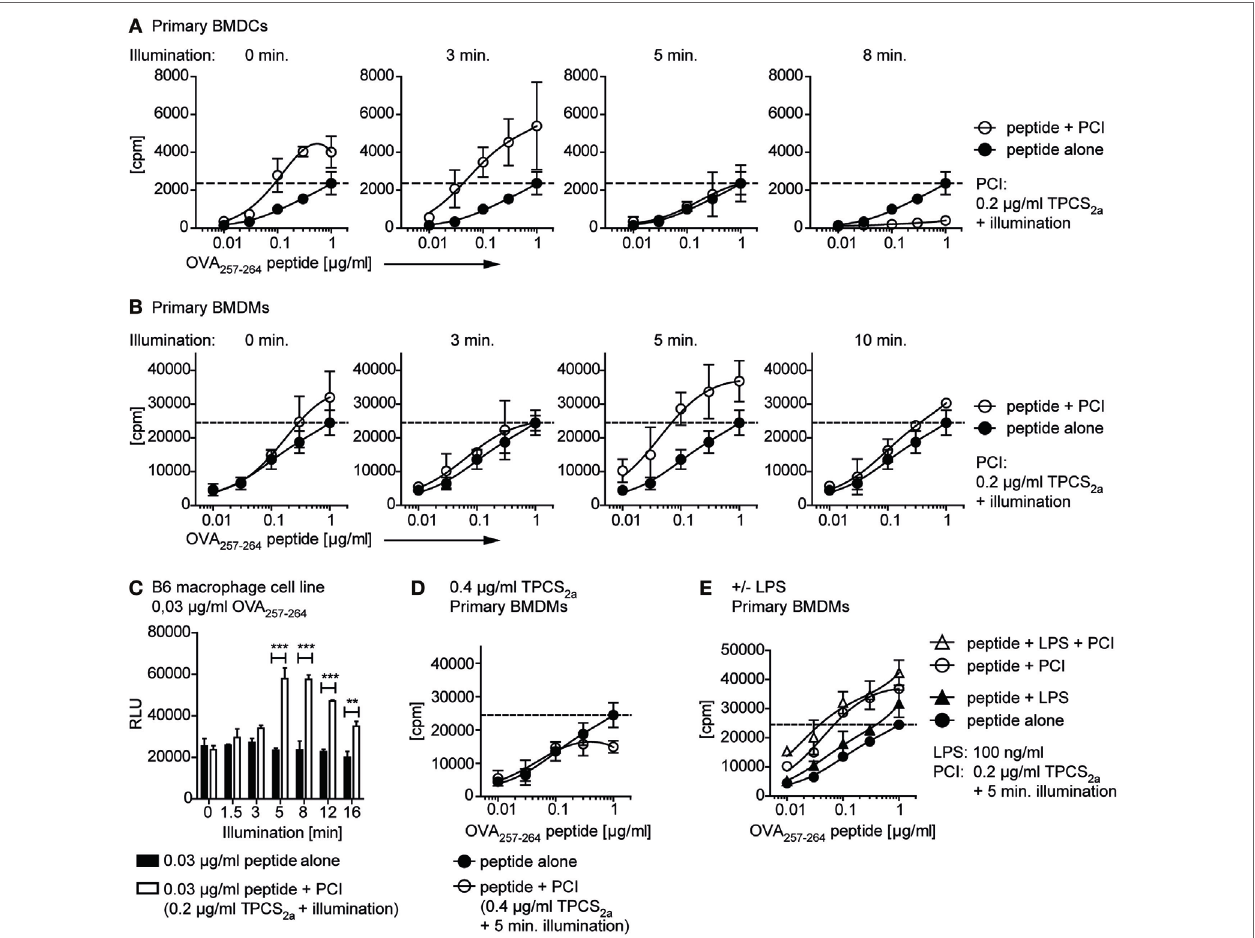
FigUre 4 | Photochemical internalization (PCI)-mediated peptide antigen delivery to antigen-presenting cells enables CD8 + T cell activation with very low doses of peptide. Primary bone marrow-derived dendritic cells (BMDCs), primary bone marrow-derived macrophages (BMDMs), or the B6 macrophage cell line were incubated ± TPCS 2a and OVA 257–264 peptide as described in Figure 3 . Cells were illuminated, before ovalbumin-specific RF33.70 CD8 + T cells were added overnight and IL-2 from activated CD8 + T cells was analyzed in a bioassay from cell culture supernatants. The PCI-effect on RF33.70 CD8 + T cell activation with 0.01–1 µg/ ml OVA 257–264 OVA 257–264 peptide was analyzed in primary BMDCs (a) and primary BMDMs (B) . The graphs show results for CD8 + T cell activation with peptide alone (closed symbols) or peptide delivered by PCI (0.2 µg/ml TPCS 2a , open symbols) and increasing illumination times from 0 to 10 min. The dotted line indicates the maximal CD8 + T cell activation achieved with 1 µg/ml OVA 257–264 peptide without PCI treatment. (c) Effect of PCI treatment on OVA 257–264 -specific CD8 + T cell activation with a single, low concentration of 0.03 µg/ml OVA 257–264 peptide and increasing illumination times. OVA 257–264 peptide was delivered to the B6 macrophage cell line without (black bars) and with PCI (0.2 µg/ml TPCS 2a , 18 h, white bars) and illuminated for 0–16 min. Experiments were performed in triplicates; P values for each illumination time were calculated using an unpaired two-tailed t -test (* P < 0.05, ** P < 0.01, and *** P < 0.005). (D) Effect of PCI treatment with a high dose of TPCS 2a (0.4 µg/ml) on OVA 257–264 -specific CD8 + T cell activation. BMDMs were incubated with 0.01–1 µg/ml OVA 257–264 peptide alone (open symbols) or peptide delivered by PCI using 0.4 µg/ml TPCS 2a and 5 min illumination. (e) Effect of additional toll-like receptor stimulation. BMDMs were treated ± lipopolysaccharide (LPS) (100 ng/ml), with or without PCI treatment (0.2 µg/ml TPCS 2a , 5 min illumination). The bioassay measured proliferation [ 3 H-thymidine incorporation in (a,B,D,e) ; cpm, counts per minute] or metabolic activity [CellTiter-Glo Luminescent assay in (c) ; RLU, relative light units] of the IL-2-dependent cell line HT-2 grown in